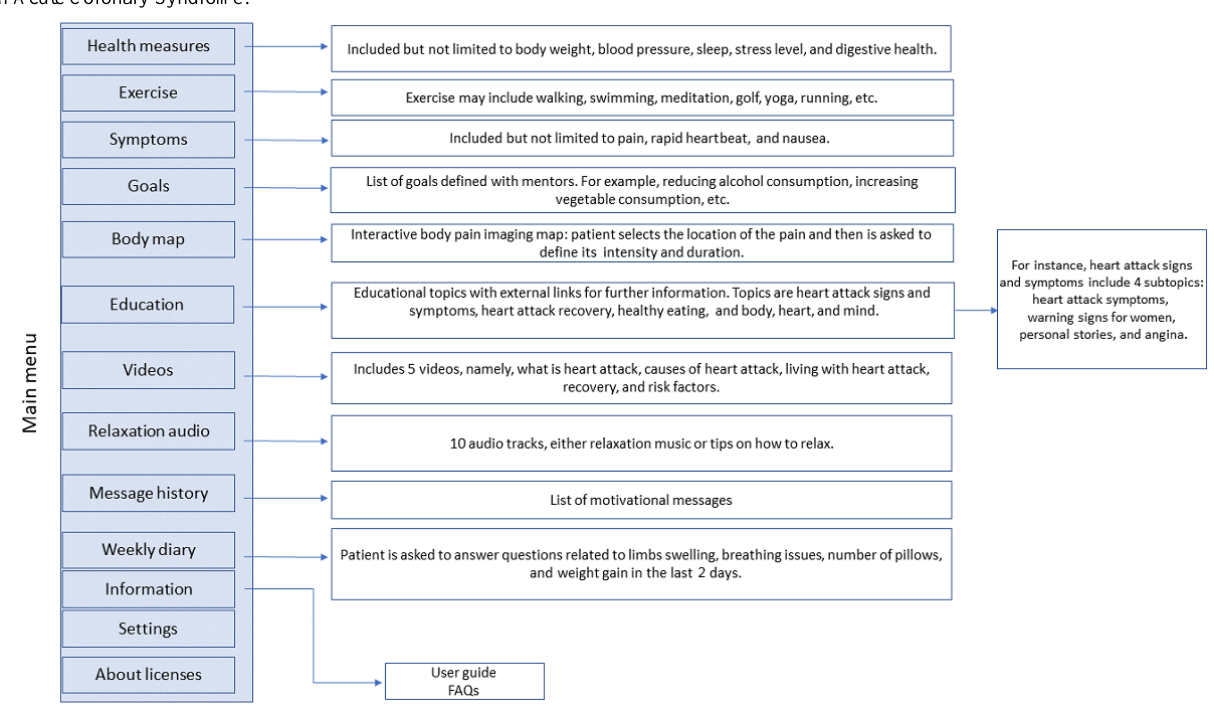
Figure 2. Navigation of the MoTER-ACS app. FAQ: frequently asked question; MoTER-ACS: Mobile Technology–Enabled Rehabilitation for Patients With Acute Coronary